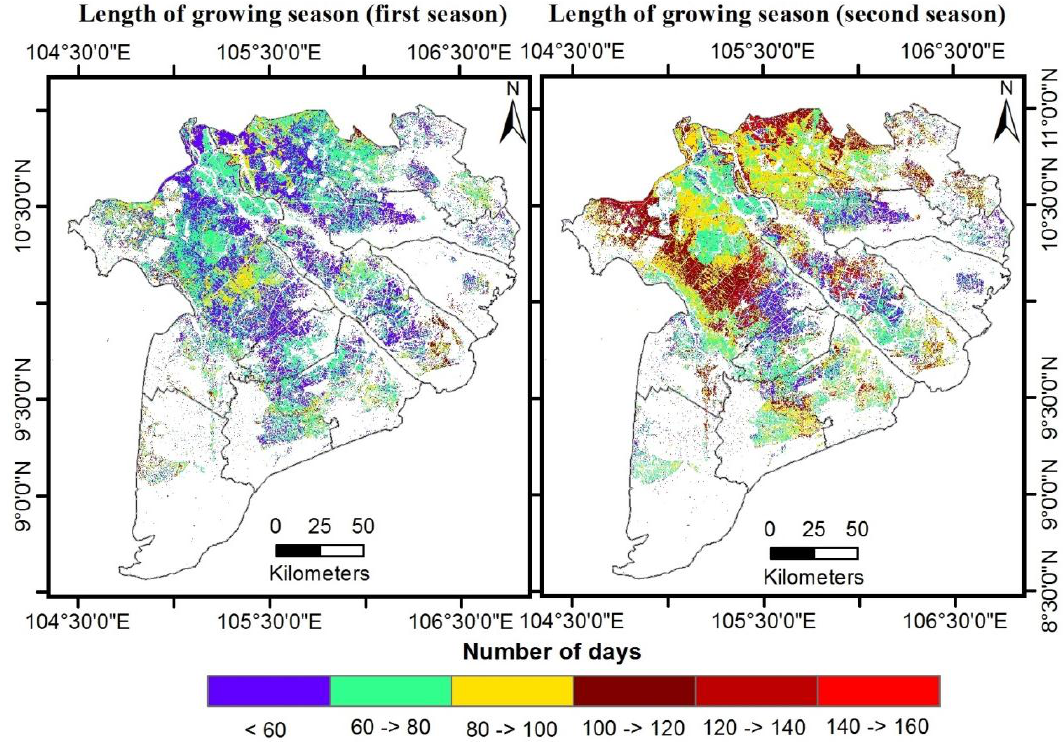
Figure 13. Length of first and second rice-growing season the Mekong Delta derived from Envisat ASAR WSM data from 2007 to 2011.